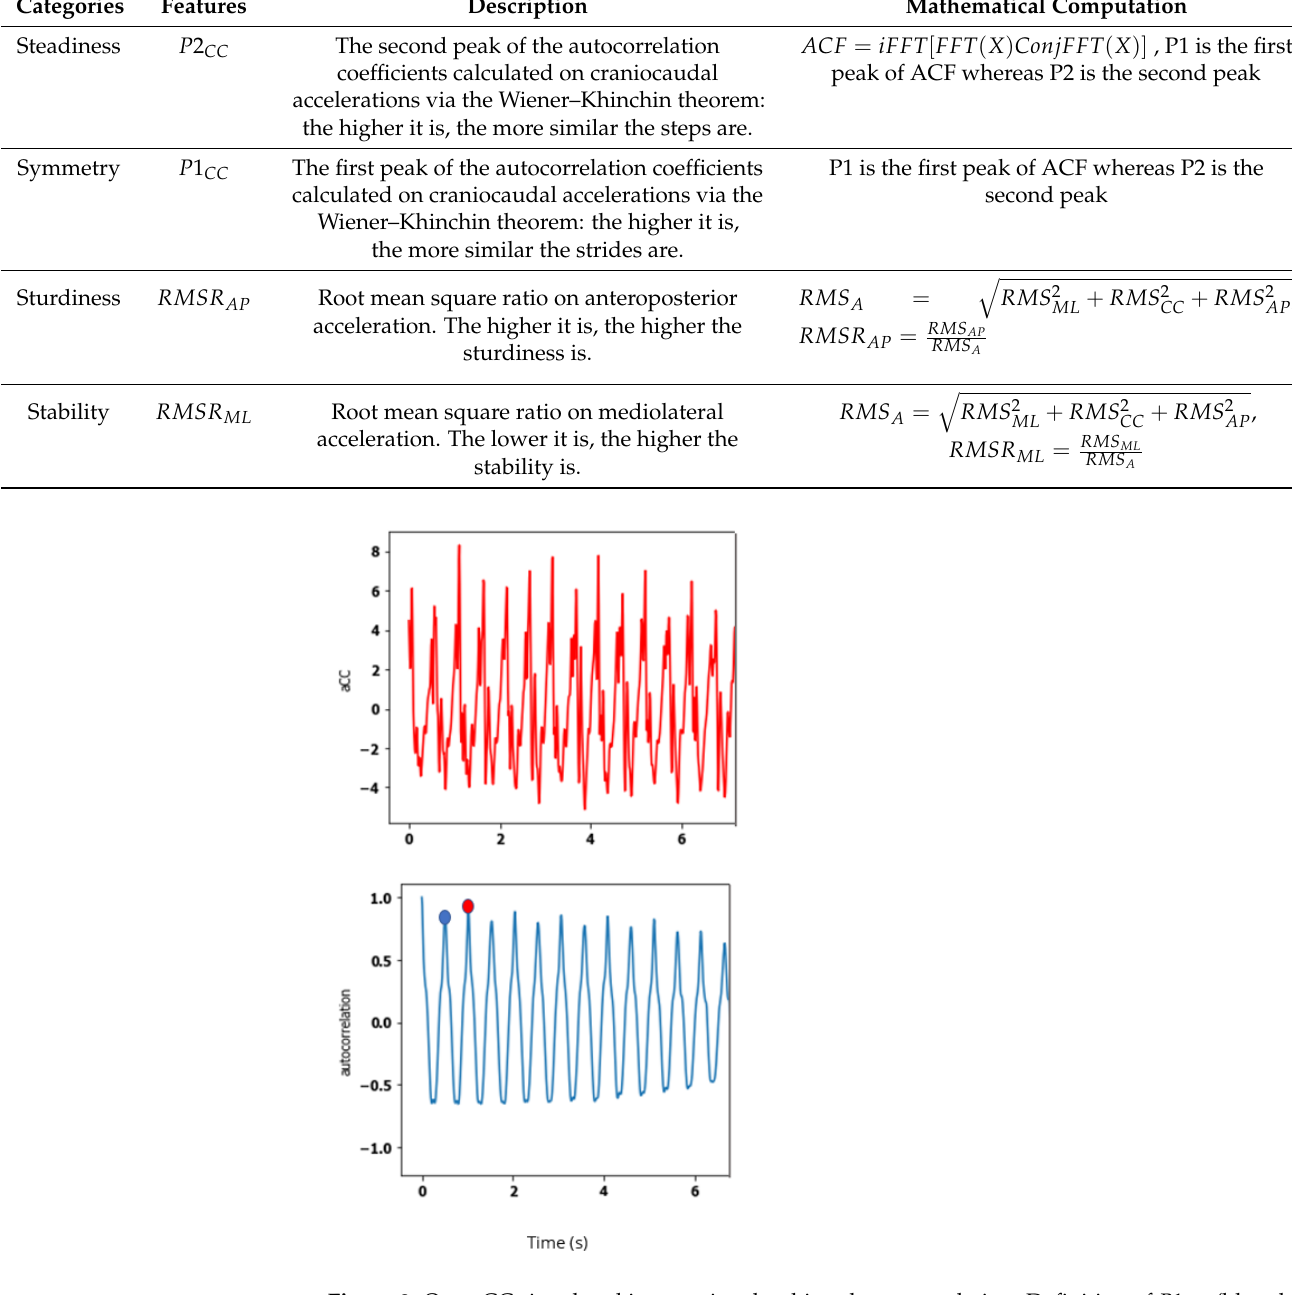
Figure 3. One aCC signal and its associated unbiased autocorrelation. Definition of P 1 CC (blue dot) and P 2 CC features (red